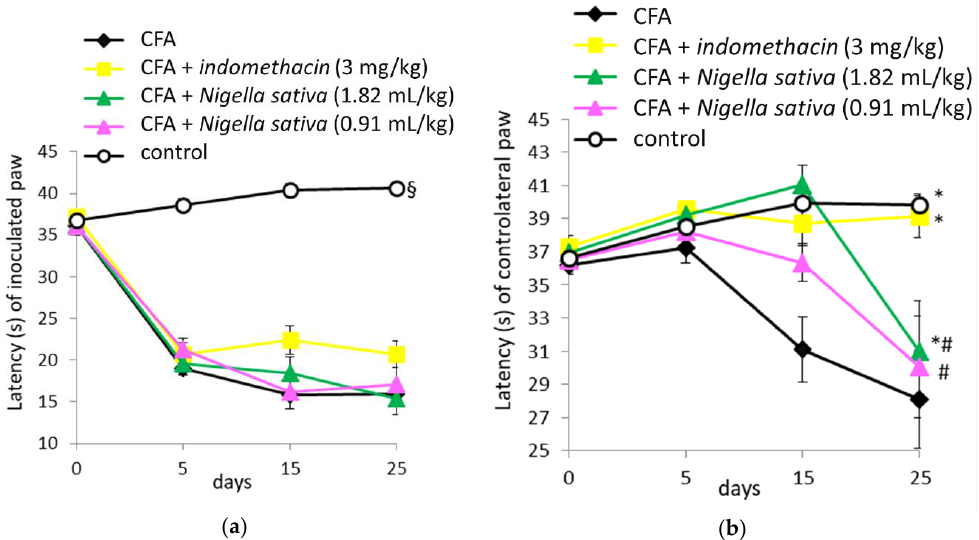
Figure6. E ff ect of Nigella sativa oil ondisease progression in CFA-induced arthriticrats. CFA-immunized rats (on day 0) received Nigella sativa oil (1.82 or 0.91 mL / kg), indomethacin (3 mg / kg) or vehicle by gastric gavage daily for 25 days. A group of non-immunized rats receiving vehicle during the same period served as a healthy control. Evaluation of mechanical allodynia in the inoculated ( a ) and controlateral ( b ) paws was performed prior to the immunization, on day 0, and up to 25 days. Data expressed as mean ± SD were analyzed using two-way repeated measures ANOVA; n = 12 rats per group except the control group with n = 11 rats. * p < 0.05 vs. CFA group; # p < 0.05 vs. control group; § p < 0.05 vs. all